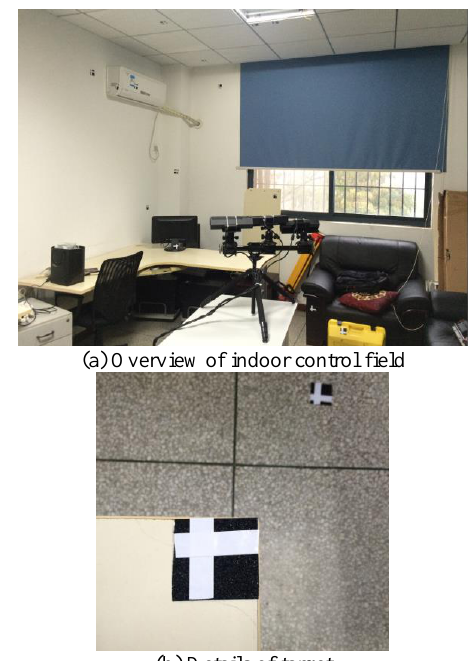
Figure 8.Calibrate sensor array with indoor control